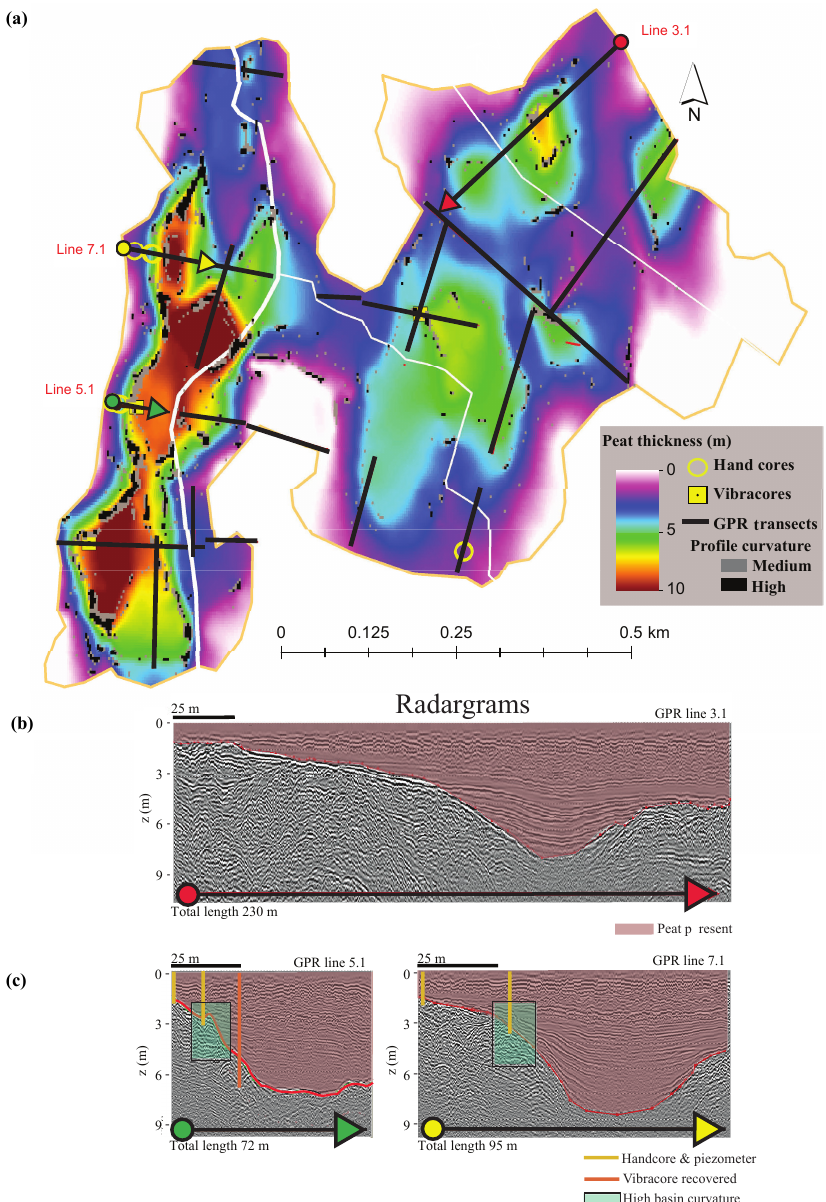
Figure 2. (a) Map of total peat thickness beneath Tidmarsh Farms based on GPR data. GPR data collected along linear transects shown here (black lines; pink lines in Fig. 1b) were interpolated and contoured to show peat thickness (colors) on the 2-D surface map. Zones of medium and high curvature (the second derivative of the thickness) of the peat–sand interface are shown as grey and black pixels, respectively. (c, d) Three example cross sectional profiles, or radargrams, illustrate a distinct reflector at the basal peat–sand contact. Peat is shaded red. Sediment cores shown as yellow lines (hand cores) and orange lines (vibracore) were used to constrain the GPR velocity data. High curvature is highlighted in green